Question: How would you classify this visualization?
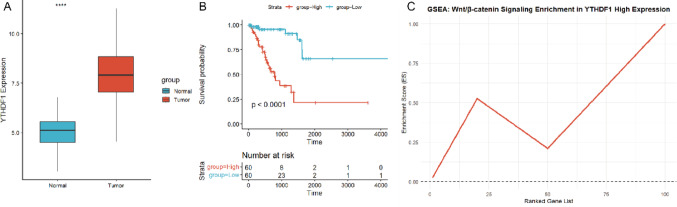
Answer: survival